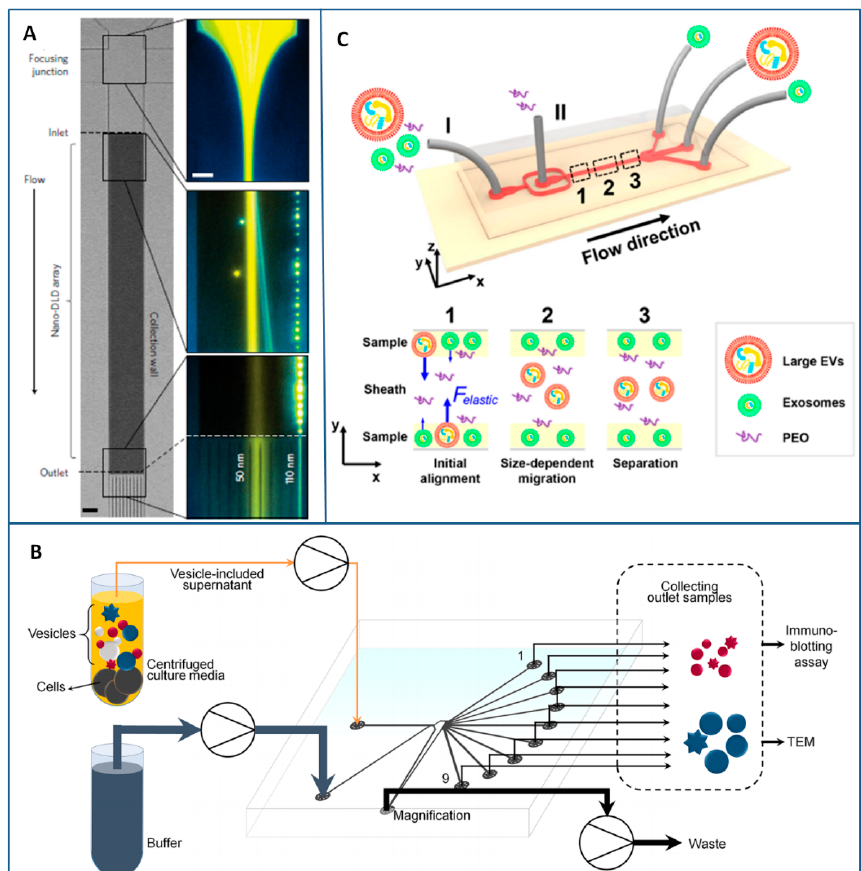
Figure 5. Flow-induced methods for exosomes separation based on Deterministic Lateral Displacement (DLD), Pinched Flow Fractionation (PFF), and viscoelastic microfluidics. ( A ) Hydrodynamically focused jet in a nano-DLD array first tested to separate polystyrene beads and the